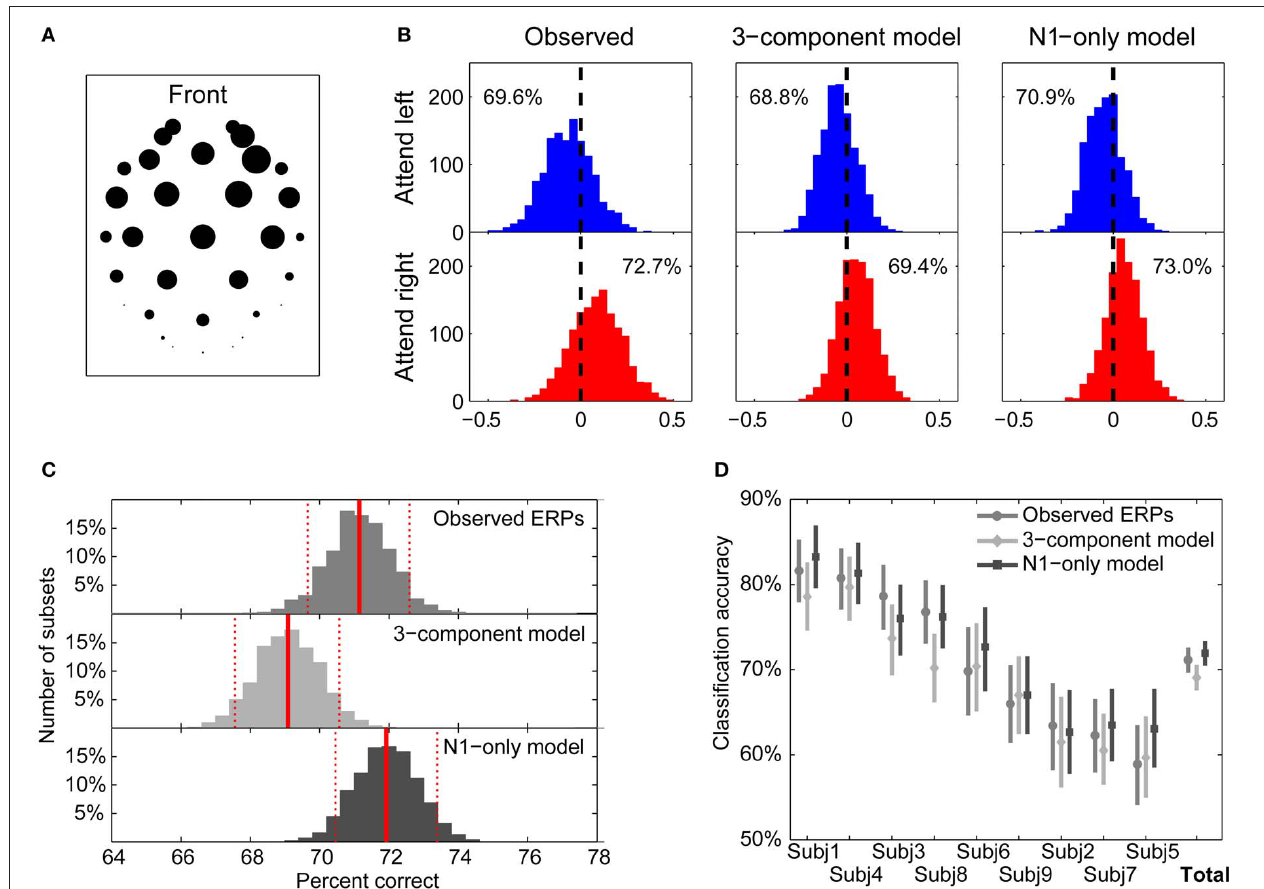
classified trials(using zero asthe decision boundary) isgiven withineach panel. (C) Bootstrap distributions of classification accuracies using the three templates. Red solid lines represent the bootstrap means, while dashed lines represent 95% confidence intervals (CIs). Templates based on the 3-component model yield statistically worse classification performance than either templates equal to observed ERPs or templates based on the N1-only model. (D) Classification accuracies for individual subjects. Bootstrap means and 95% confidence intervals (CIs) are shown for each of the templates. For all subjects, performance is better than chance for all three template